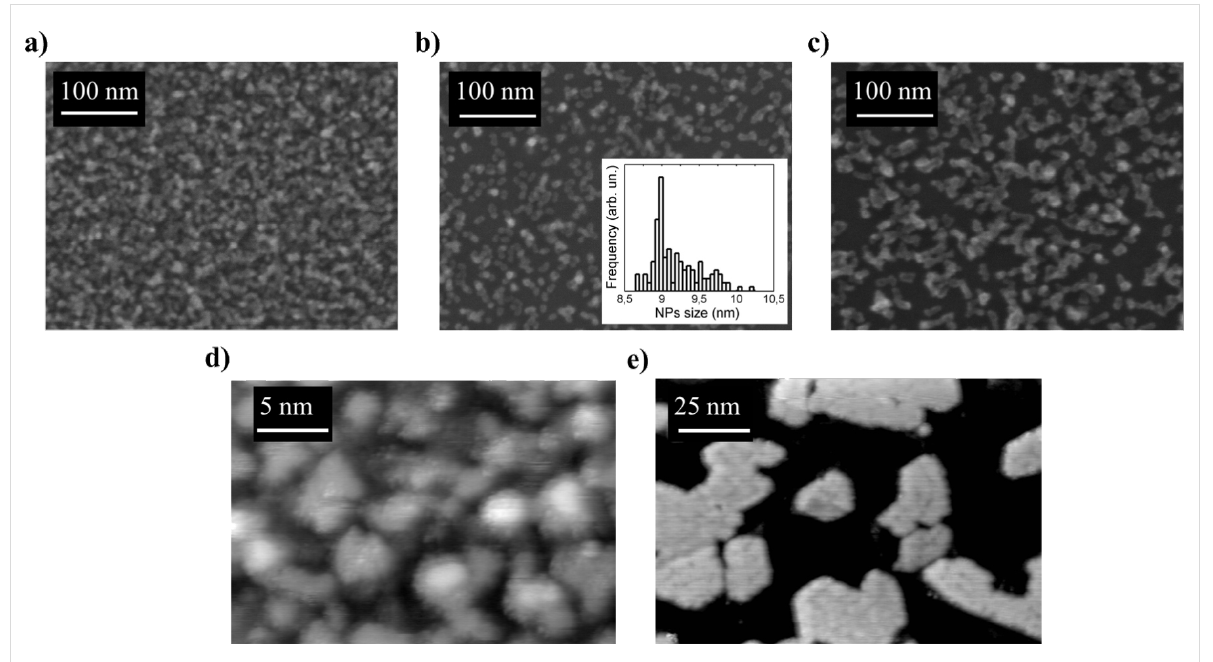
Figure 2: SEM images of NPs films: NPs diameter 6 nm (a), NPs diameter 9 nm (lateral size distribution in the inset) (b) and NPs diameter 14 nm (c). STM images of the non-epitaxial (d) and epitaxial (e) ultra-thin ceria films acquired at 1.5 V and 0.04 nA.